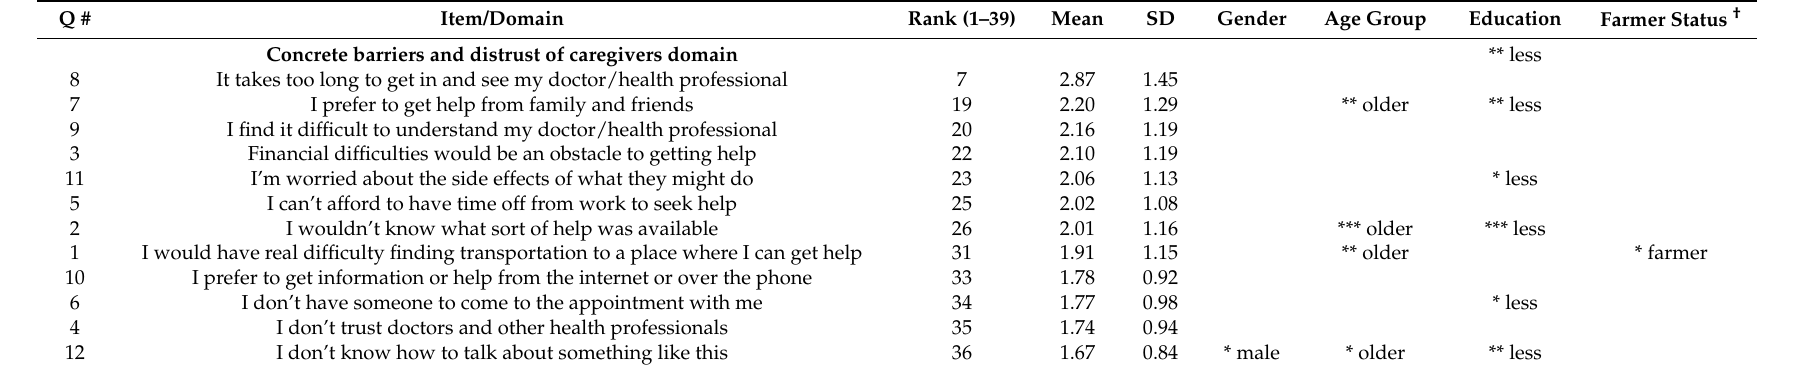
Table 3. Individual item barrier mean scores and variation in scores by demographic